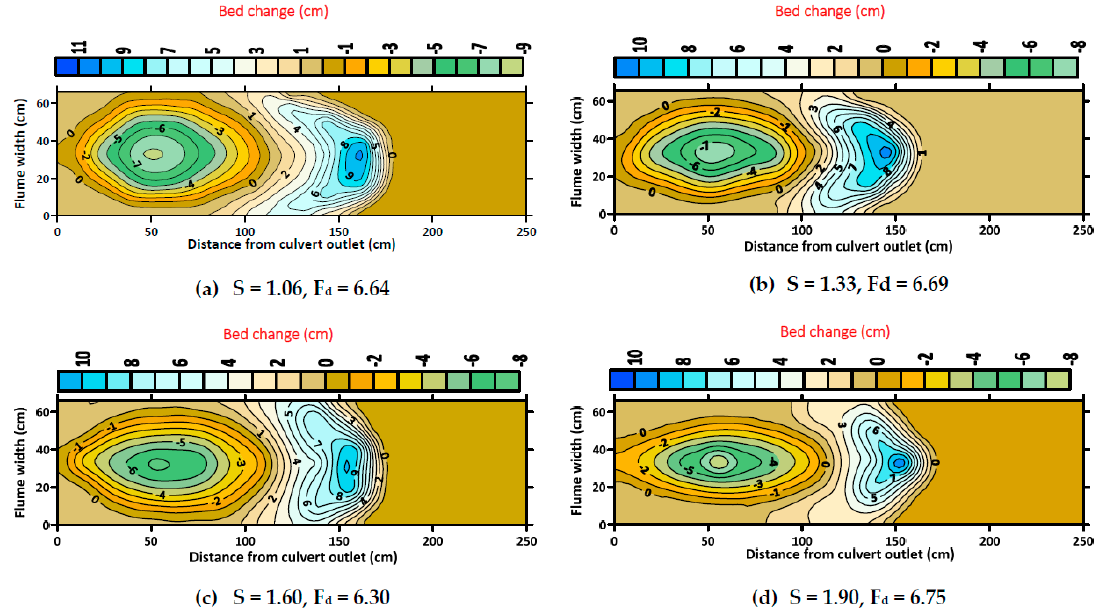
Figure 6. Scour contour maps downstream of circular culvert at Ar = 0.0 ( a ) S = 1.06, F d = 6.64, ( b ) S = 1.33, F d = 6.69, ( c ) S = 1.60, F d = 6.30, ( d ) S = 1.90, F d = 6.75.